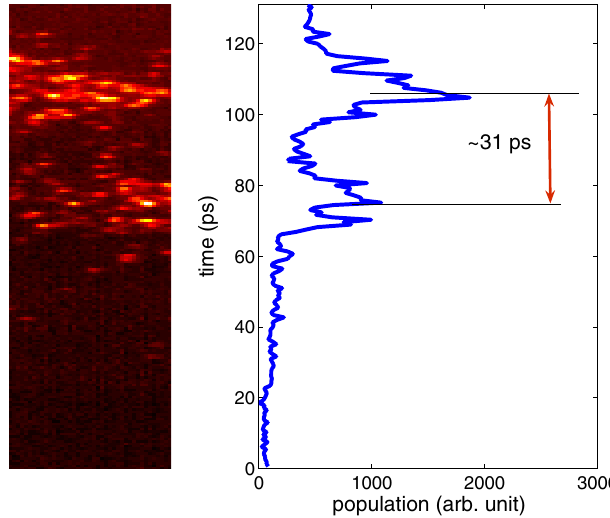
FIG. 2. (Color) Streak camera image (left) and corresponding time-profile (right) of a two-pulse laser. In this example the separation between the two pulses is approximately 31 ps. The apparent intensity difference between the two pulses (noticeable on the profiles) is an artifact of the measurement (slight mis- alignment of the second pulse on the streak camera entrance slit).